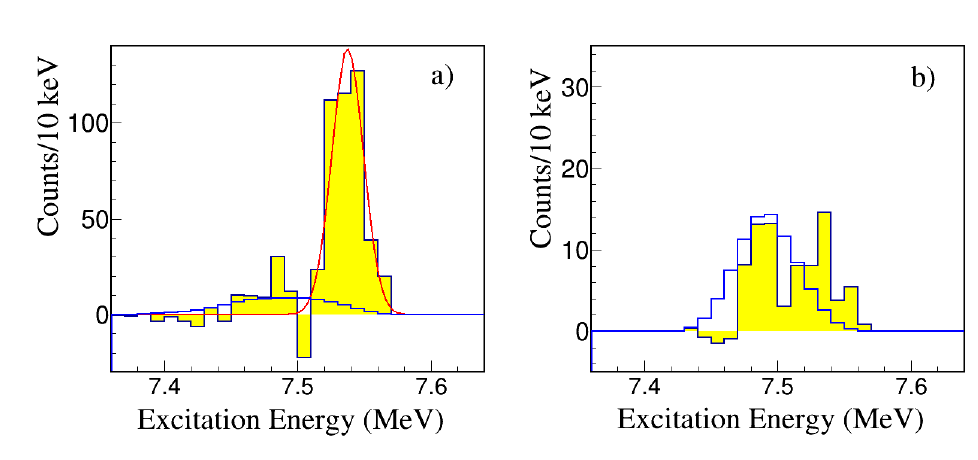
Figure 1. The filled yellow spectra are the experimental events compatible with the decay of the TE state; a) assuming sequential α + 8 Be decay; b) assuming direct 3- α decay. The blue histograms are simulated TE decay spectra in the two decay modes. The red Gaussian line is a fit of the extra-peak observed in the sequential decay